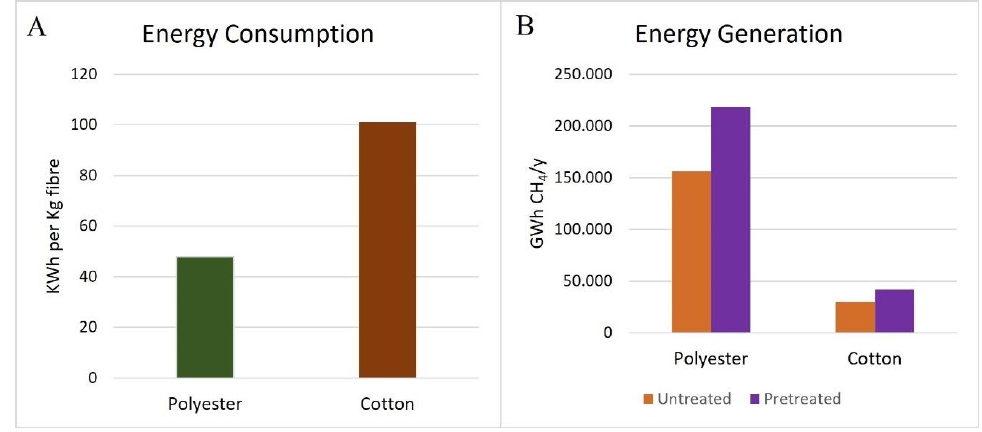
Figure 4. Consumption and generation of energy from the main textile fibers (cotton and polyester). ( A ) Energy consumption per kilogram of textile fiber produced, adapted from [1]. ( B ) Global energy generation potential from polyester and cotton untreated (orange) and pretreated (purple).